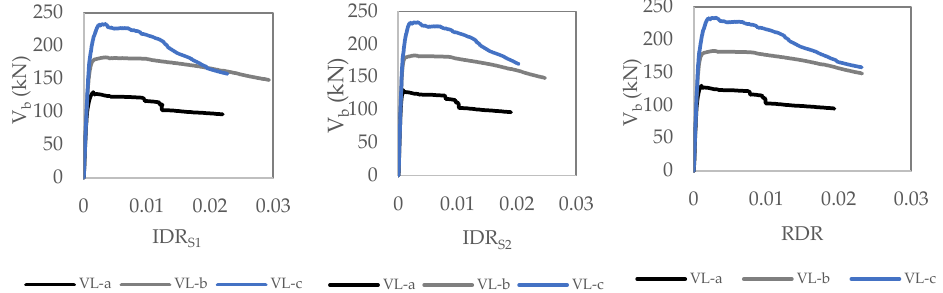
Figure 5. PO curves obtained for VL-a, VL-b, and VL-c. The three plots report the IDR of the first level ( left ), the IDR of the second level ( centre ), and the RDR ( right ) of the masonry wall.